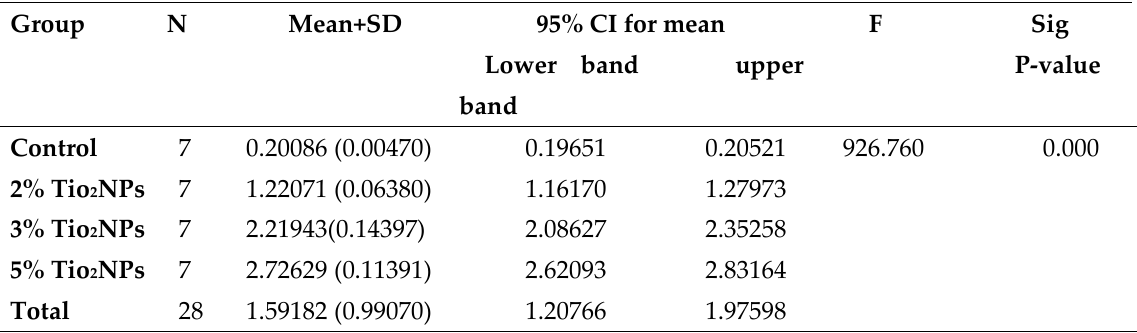
Table 3 : One-way ANOVA test for C.